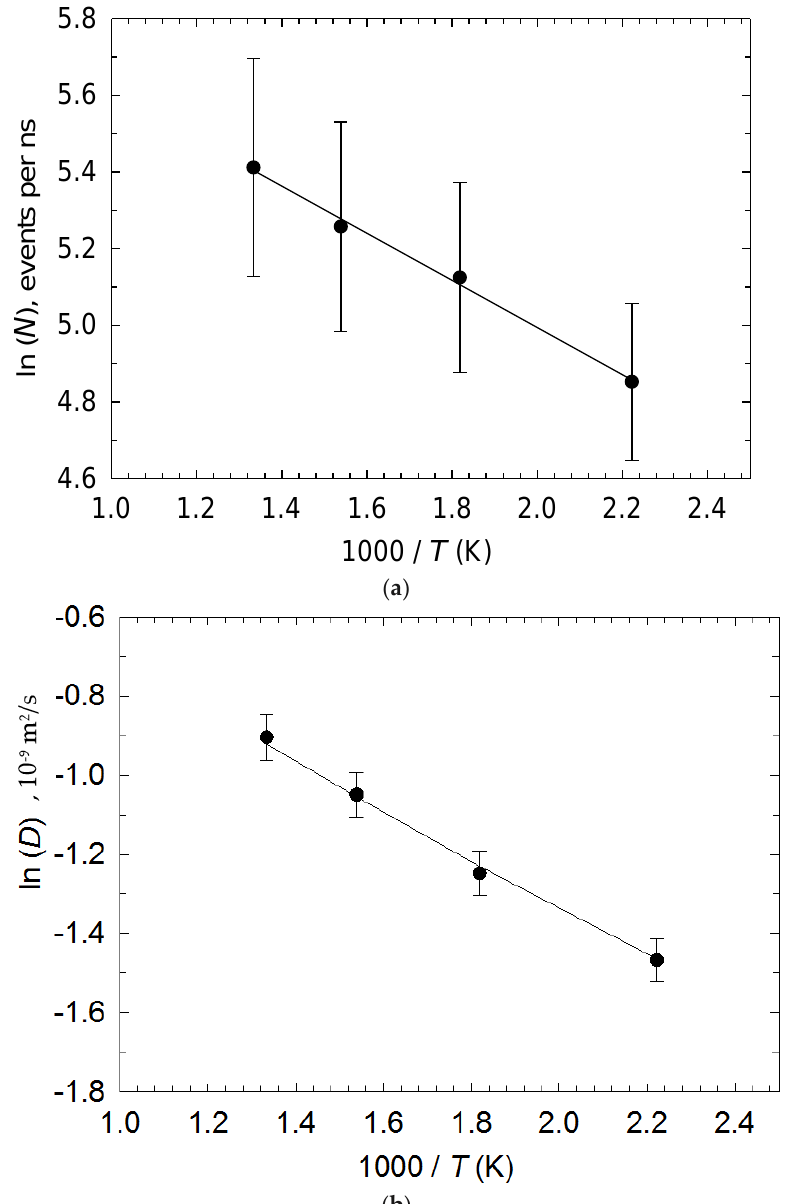
Figure 5: Arrhenius plots of ( a ) number of reactions per nanosecond, N , and ( b ) self-diffusivity, D (from Figure 3a), with error bars. The r 2 of both linear-regression lines is over 99%. A Student’s t -test on the resulting N - and D - activation energies establishes non-rejection of H 0 (see main text).